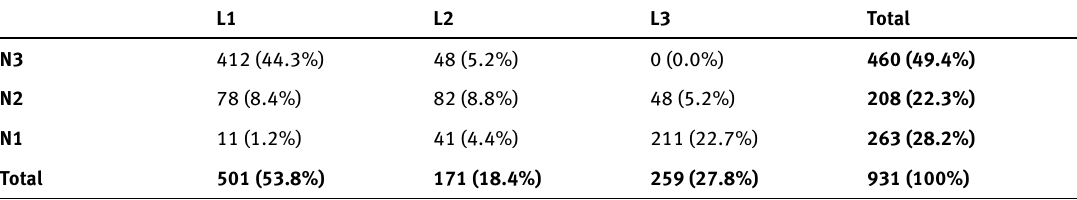
Figure 10: Breakdown of 931 fingerspelling tokens by annotation type Table 3: Distribution of fingerspelling-related tokens by number of letters (L) and nativisation